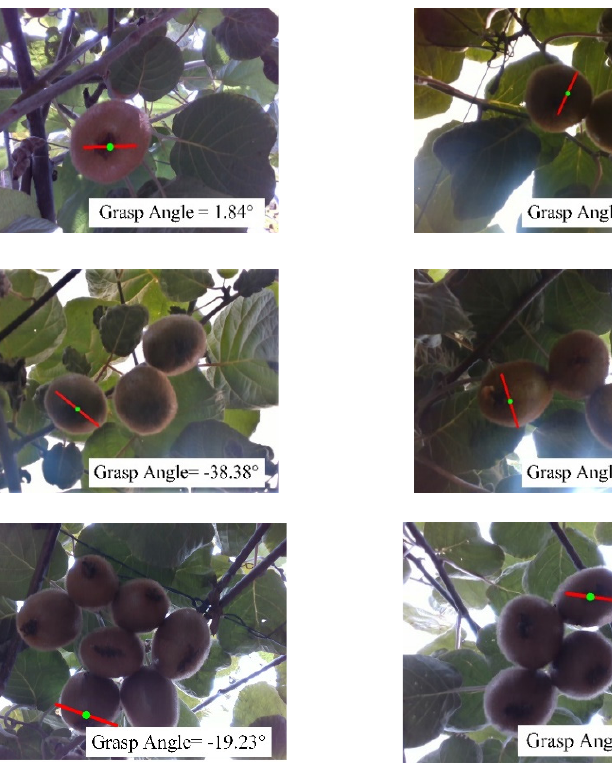
Figure 8. Test results of grasping detection.